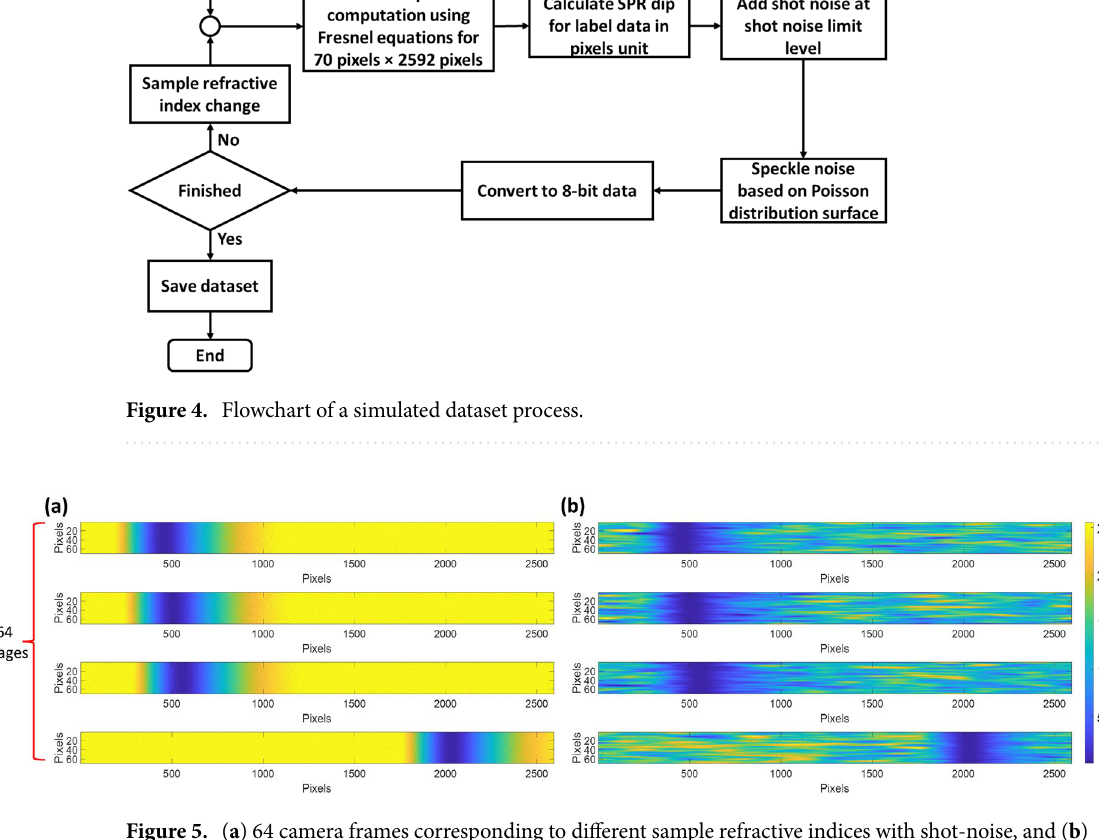
Figure 5. ( a ) 64 camera frames corresponding to different sample refractive indices with shot-noise, and ( b ) shot-noise and speckle pattern added camera frames.